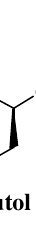
FIGURE 4. Structure of